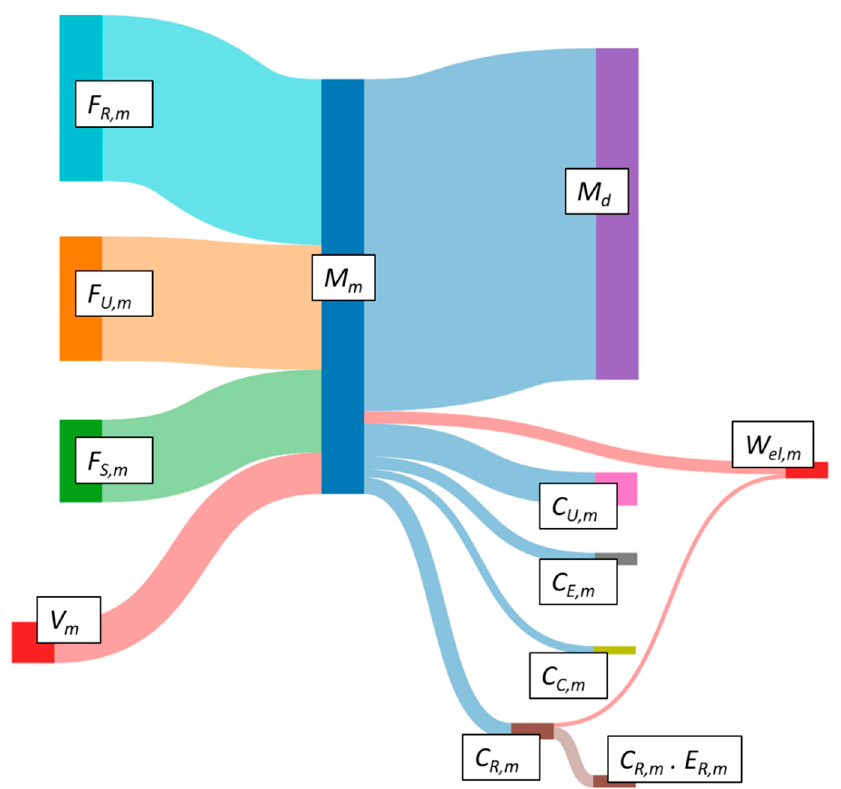
Figure 4. Flow of the different material fractions to be measured on the element level in the construc- tion phase.